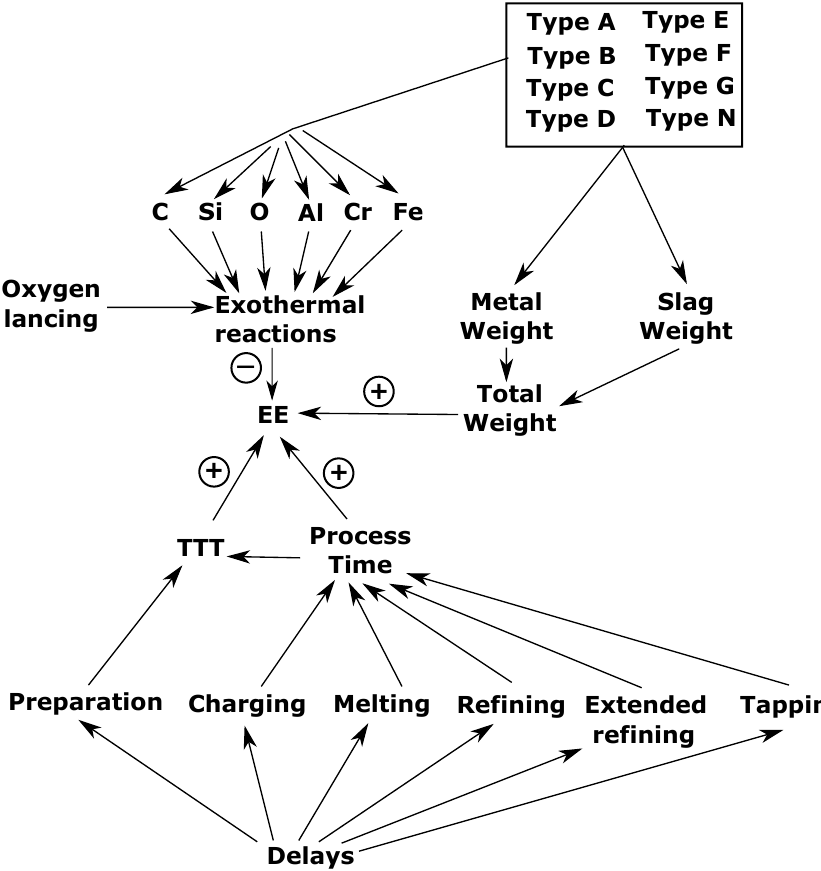
Figure 2. Graph-model describing the expected correlations between the input variables and the output variable in a statistical model predicting the EE consumption. The arrows illustrate the correlative relation between the variables. The circled signs illustrate the positive or negative contributions imposed on